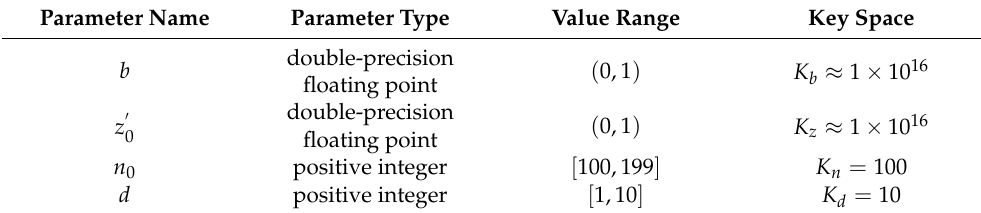
Figure 6. The first row shows the reconstruction results using the right initial value. The second row shows the reconstruction results using the initial value that is modified 10 − 15 . The third row shows the reconstruction results using the initial value that is modified 10 − 16 . The fourth row shows the reconstruction results using the initial value that is modified 10 − 17 . Table 4. Secret key space